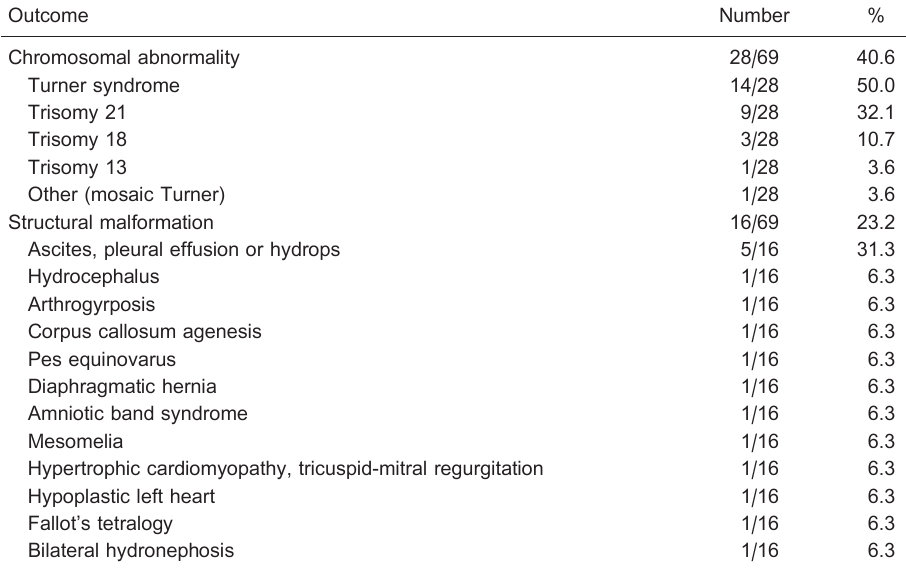
Table 1. Septated cystic hygroma: chromosomal and structural abnormalities (n=69). Outcome